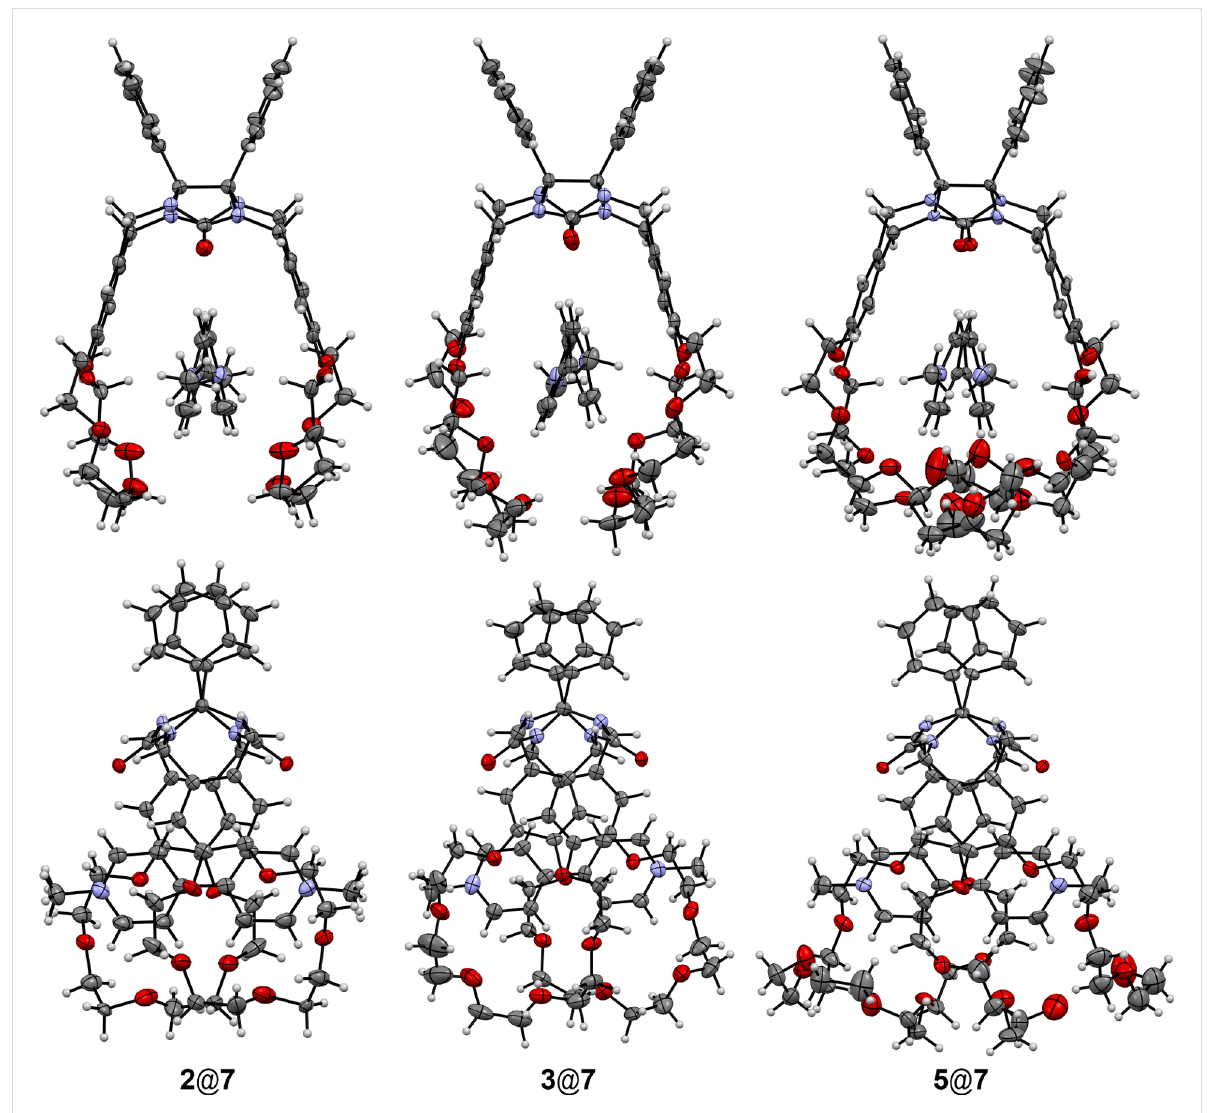
Figure 6: Molecular structures of complexes of clips 3 , 2 and 5 with paraquat ( 7 ). Anions and solvate molecules are omitted for clarity.